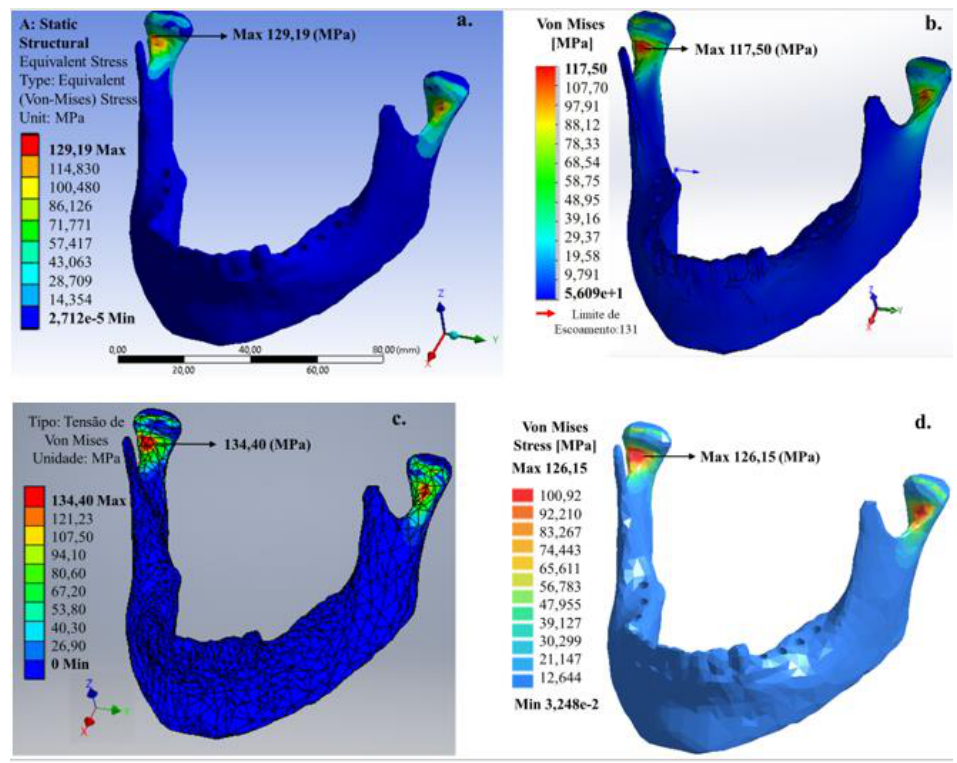
Figure 4. Von Mises stress distribution in the mandible applying 200 N load on the right and left lateral area of the lower dental arch: ( a ) Ansys ® , ( b ) SolidWorks ® , ( c ) Inventor ® and ( d ) SimSolid ® software.